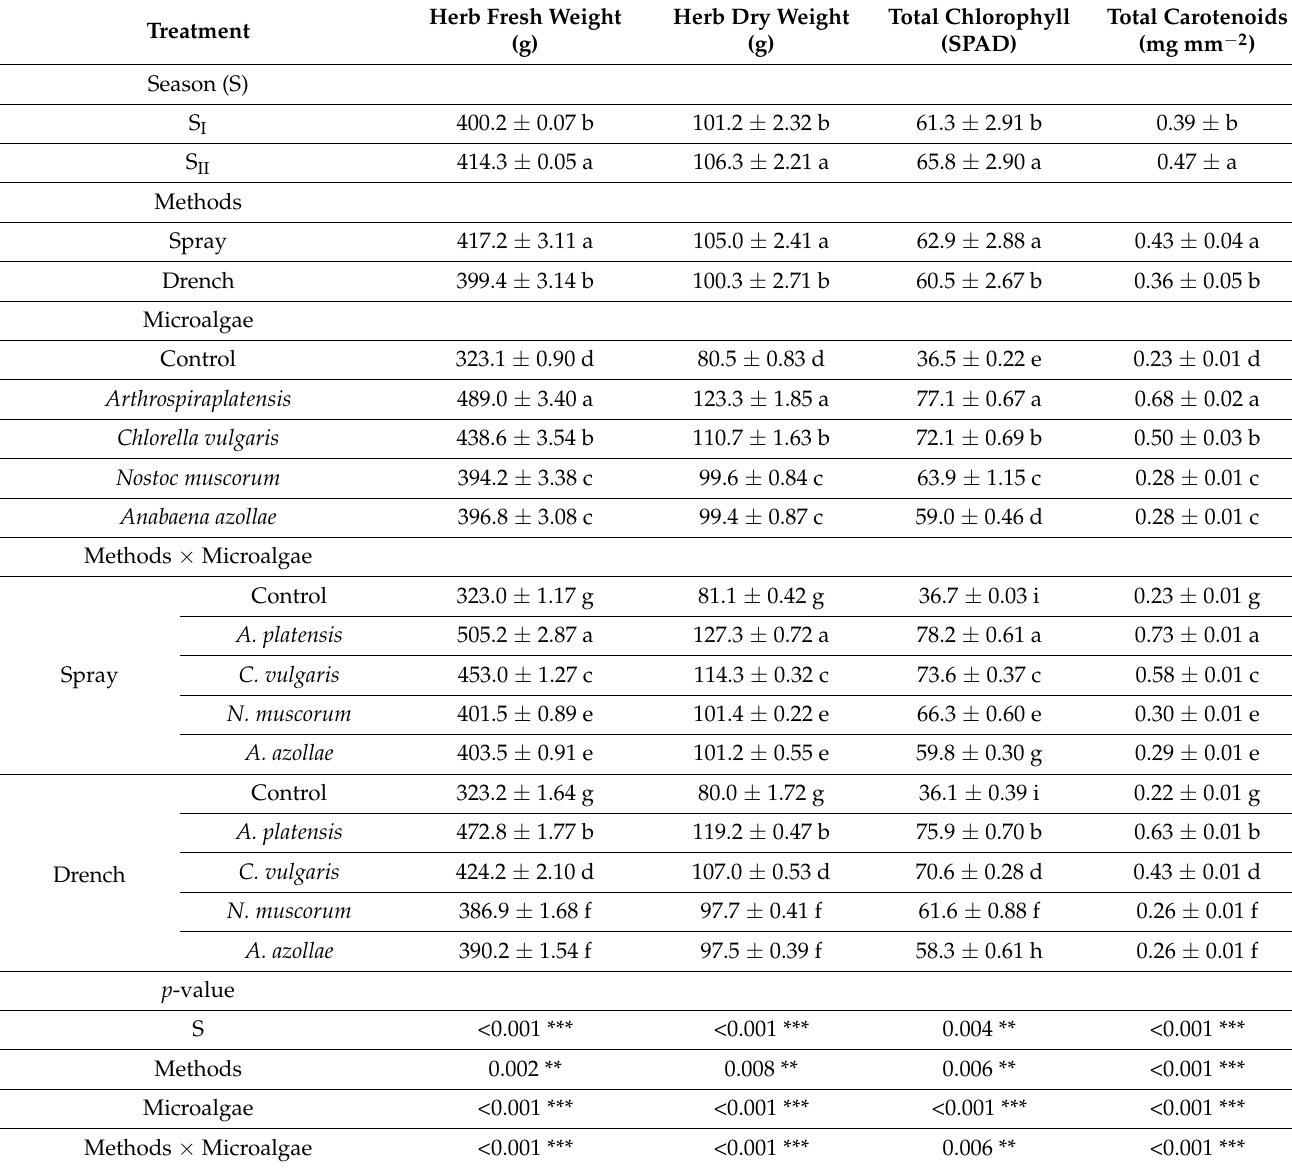
Table 2. Herb fresh and dry weights and total chlorophyll and carotenoid contents of chia plants cultivated under alkaline stress conditions in response to different application methods, microalgae strains, and their